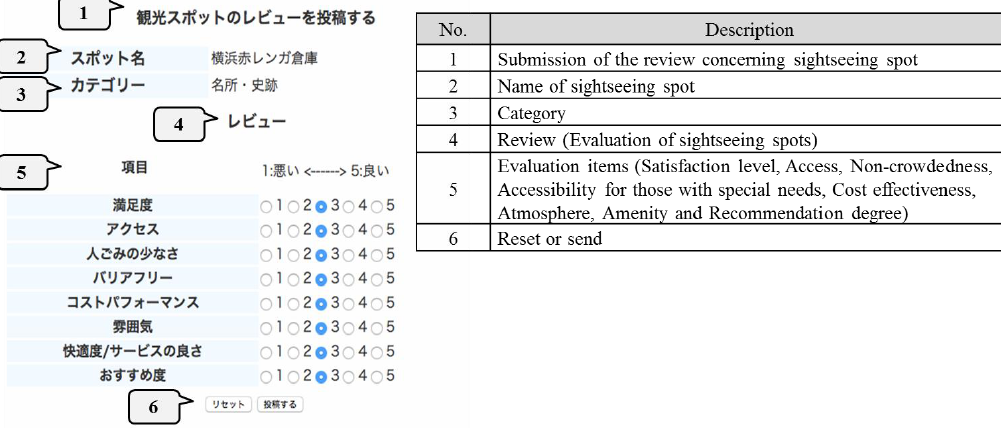
Figure 4. Page for the evaluation function of sightseeing spots.